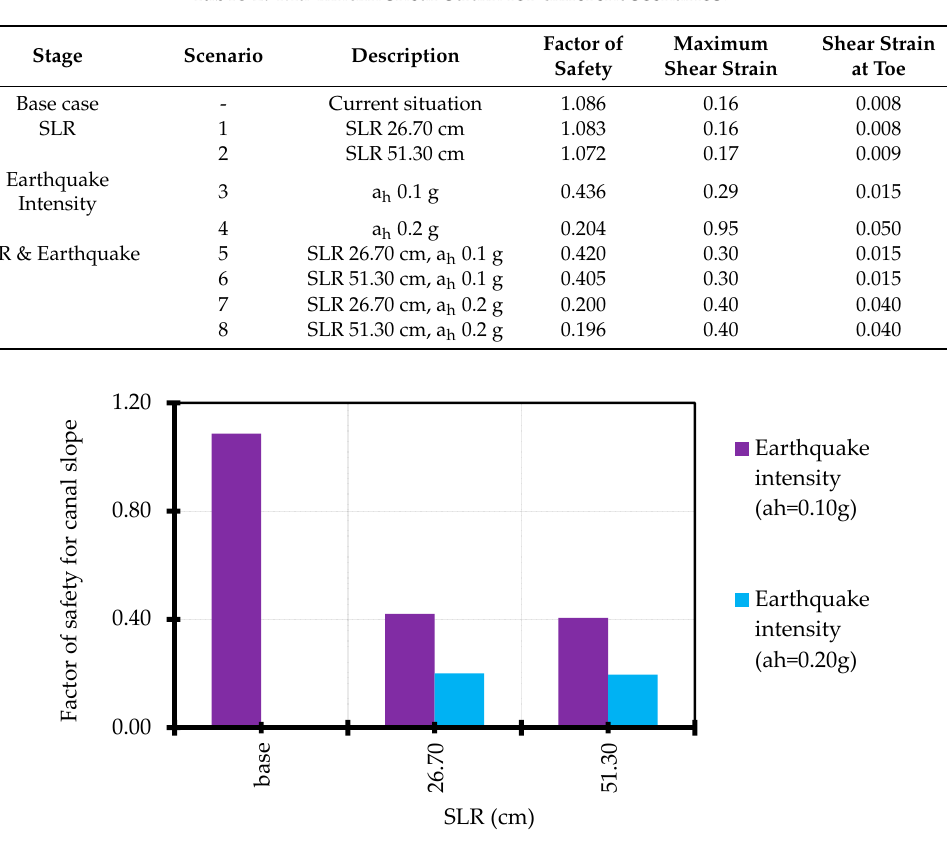
Figure 20. Canal factor of safety for combination of SLR and earthquake intensity.